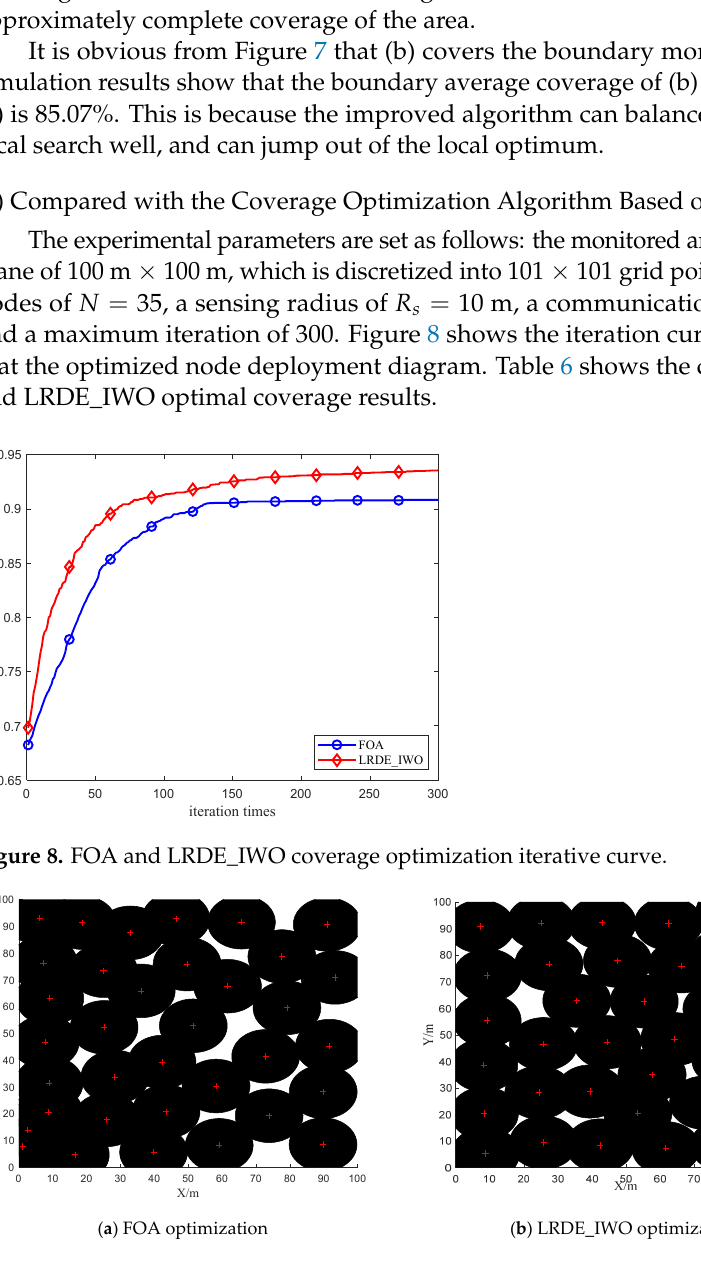
Figure 9. Node distribution optimized by FOA and LRDE_IWO. Table 6. Comparison of the optimized coverage results between FOA and LRDE_IWO.